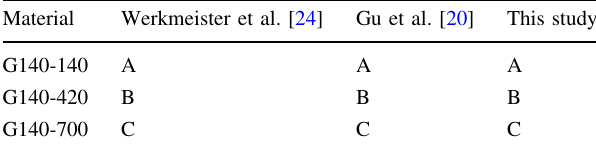
Table 9 Criteria for shakedown ranges for selected materials